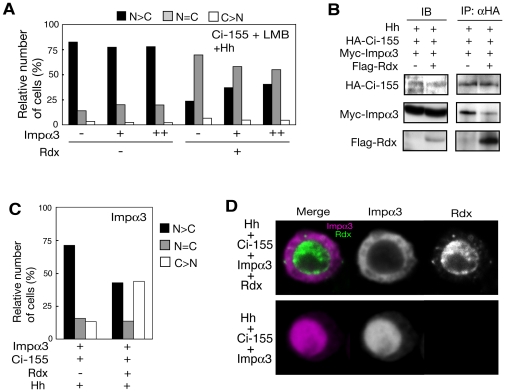
Rdx inhibited the nuclear import of Ci-155 by competing with importin α3 for binding to Ci-155.(A) Importin α3 counteracted the Rdx-mediated inhibition of nuclear import of Ci-155. HA-Ci-155 was expressed in clone-8 cells, with or without Rdx and varying amounts of importin α3. Cells were treated with LMB and the subcellular localization of Ci-155 was examined as described above (number of cells examined: 200–250). (B) Rdx competed with importin α3 for binding to Ci-155. Clone-8 cells were transfected with the HA-Ci-155, Myc-importin α3 or Hh expression plasmids, in the presence or absence of the Rdx expression plasmid. Lysates from the transfected cells were immunoprecipitated with anti-HA antibody, and the immunocomplexes were analyzed by western blotting to detect the proteins indicated on the left. (C and D) Rdx inhibited the nuclear localization of importin α3. Clone-8 cells were transfected with the Ci-155 and Myc-importin α3 expression plasmids, in the presence or absence of the 2xFlag-Rdx expression vector. Cells were immunostained with the anti-Myc antibody. Cells were scored as described in Fig. 2 (number of cells examined: 80–100) (C). Typical cells immunostained with the anti-Myc and anti-Flag antibodies are shown (D).